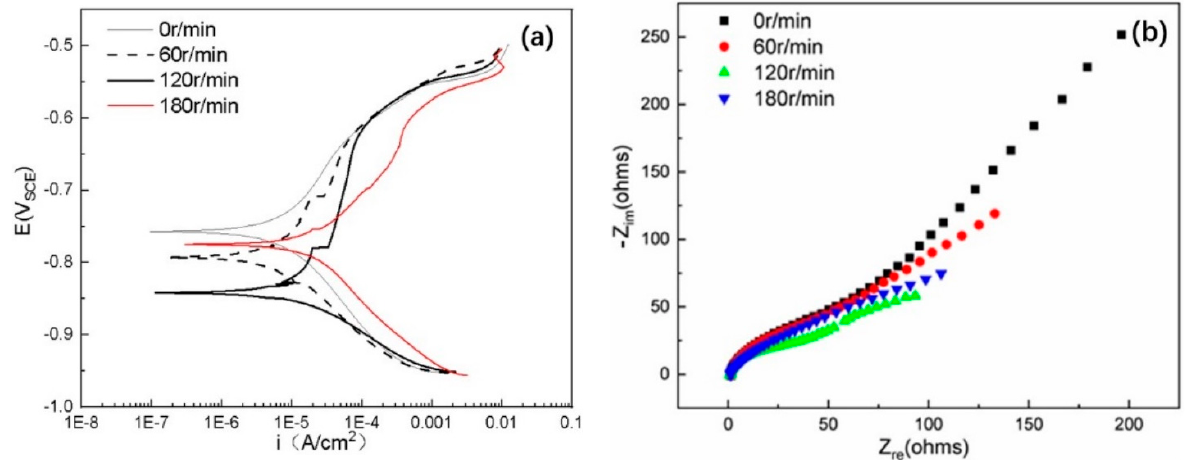
Figure 8. Polarization curves and EIS impedance curves of P110 steel at different flow rates: ( a ) polarization curves; ( b ) EIS curves.